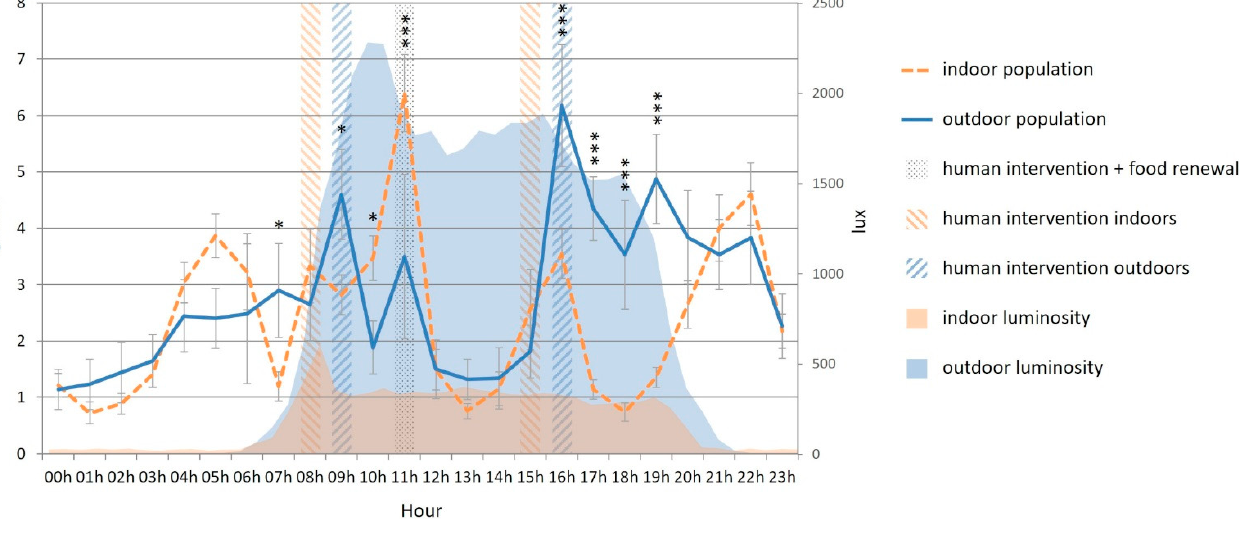
Figure 12. Mean food consumption (g, every hour) of the cats throughout the day according to their housing condition (indoors (n = 15) versus outdoors (n = 8)). Error bars represent standard errors, (*) indicates p < 0.05, (***) indicates p < 0.001.